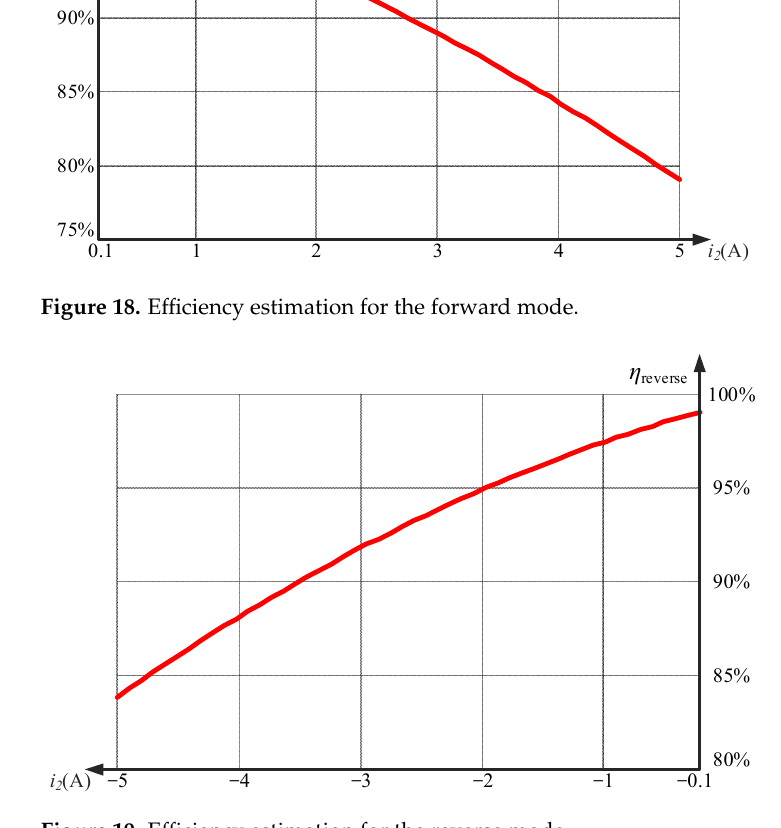
Figure 19. Efficiency estimation for the reverse mode.